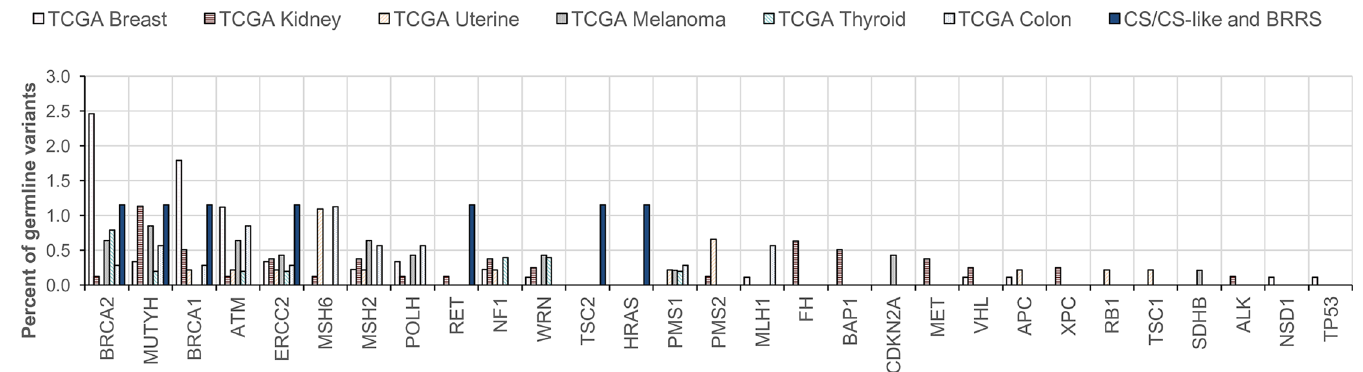
Fig 2. Comparison of pathogenic and likely pathogenic germline variant spectra and frequencies in CS/CS-like/BRRS patients and TCGA apparently sporadic component cancer patients. Solid-filled bars represent identified variant positive CS/CS-like and BRRS patients. Striped bars represent TCGA cancer patients with different colors indicating different cancer types. TCGA cancer types were selected because each is a PHTS component cancer. Abbreviations: CS, Cowden syndrome; BRRS, Bannayan-Riley-Ruvalcaba syndrome; OR, odds ratio; CI, confidence interval. (S1 Fig, S5 Table). Germline gain-of-function HRAS duplications have been reported in Cos-